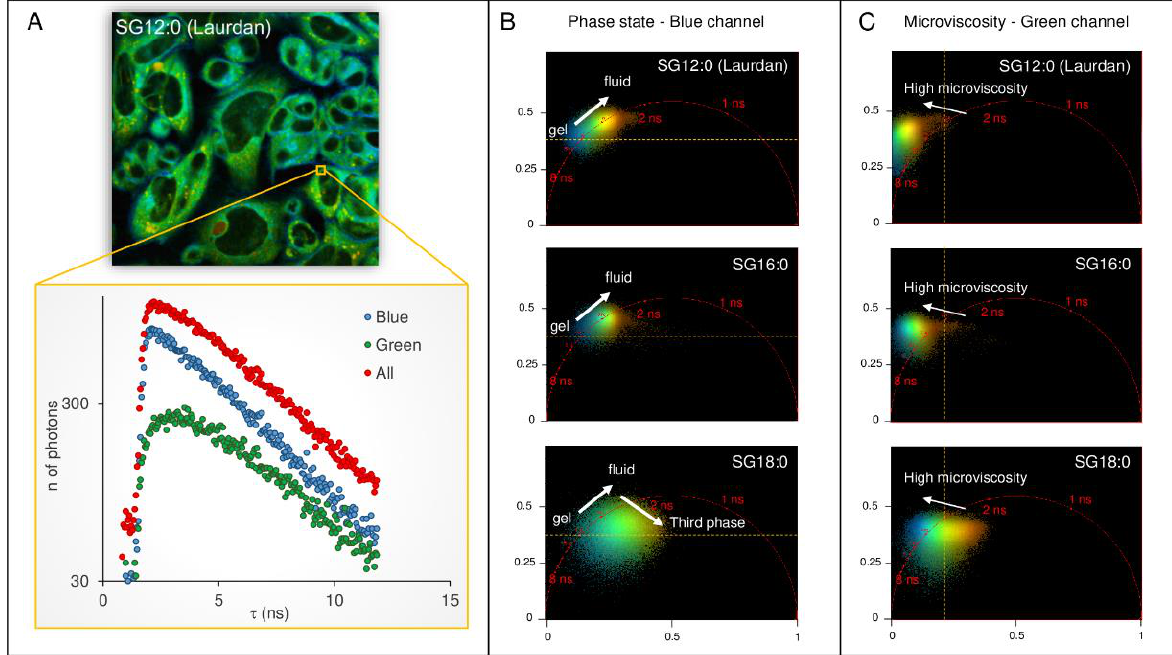
Figure 4. Spectrally resolved phasor analysis of fatty acid derivatives fluorescence. ( A ) The decay from a sample region of the cell is reported for the blue channel, the green channel, and whole spectrum. While the decay of the blue channel appears as a single exponential in the log-lin scale of the graph, the excited-state decay in the green channel presents two apparent decays: one is due to the decay of the standard fluorescence emission from the relaxed state, and the other is an apparent decay time due to the populating process from the locally excited state to the relaxed state. The two processes give rise to a visible non-exponential decay in pixels showing a very high value of microviscosity. The phasor distribution integrated for SG12:0 cells ( n = 15) is shown for the ( B ) blue channel and the ( C ) green channel. While the center of mass of the phasor lies along the universal circle for the blue channel indicating exponential decay, the phasor of the green channel lies outside of the universal circle for the control cells, indicating a non-exponential decay. Upon increasing of the aliphatic chain length, the point rotates towards the universal circle.